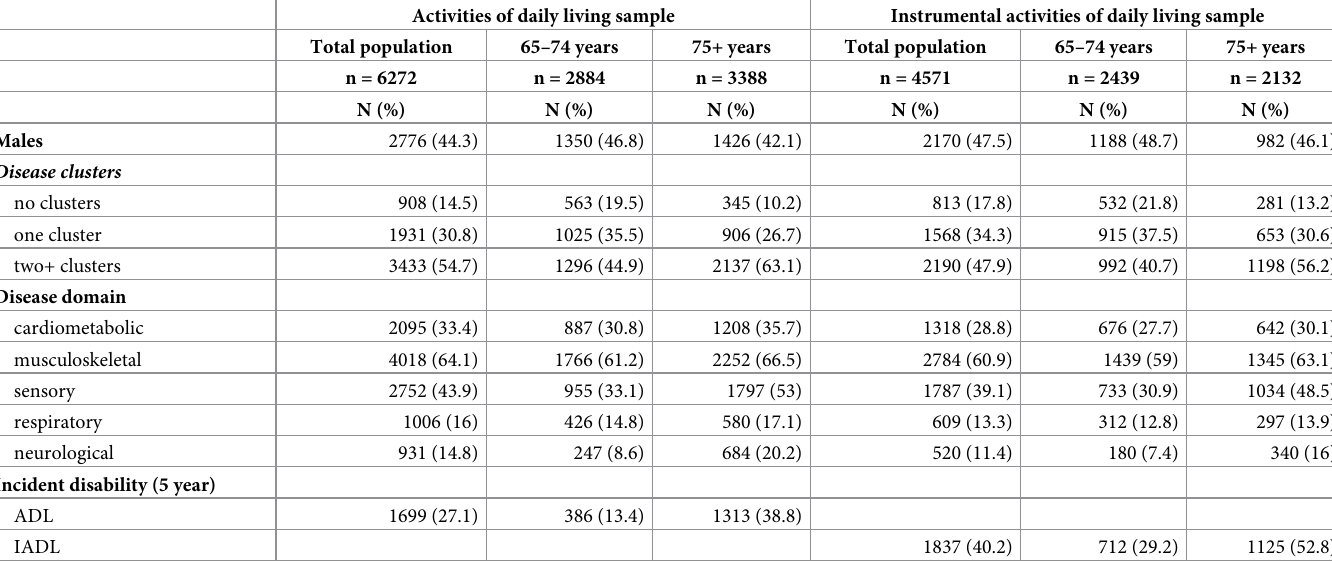
Table 1. Distribution of disease clusters and incident disability in the Canadian Survey on Health Aging, stratified by age.